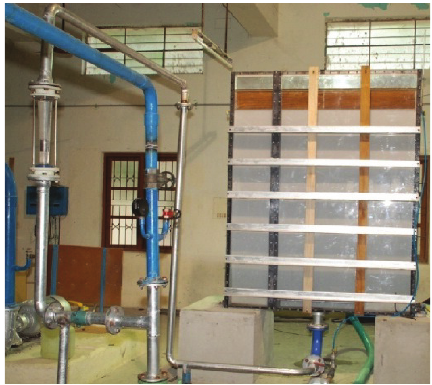
Figure 2: Photographic view of experimental setup.